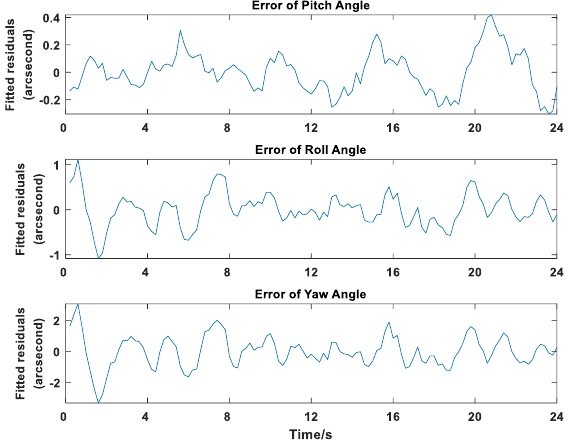
Figure 8. Residual Results of Attitude Fitting.